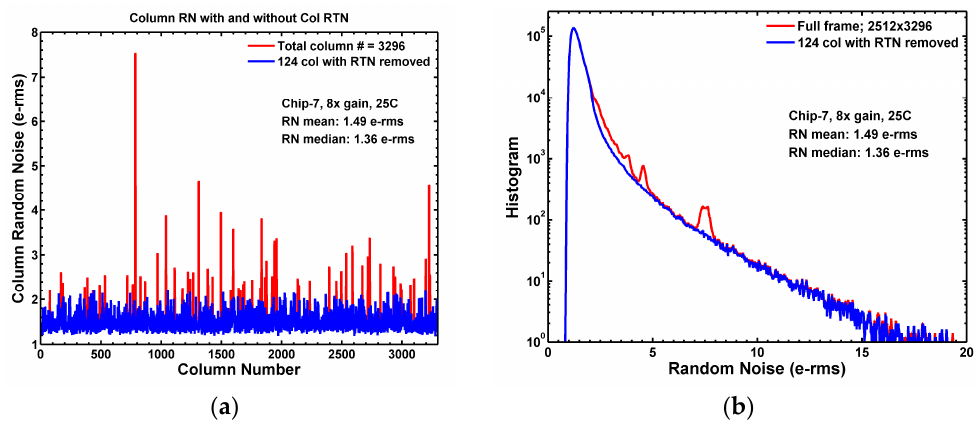
Figure 23. Column RN and pixel RN. ( a ) The column RN is defined as the average of the RMS of pixel RN for all pixels on the same column. The columns showing high noises are suspected to have RTN traps in the column bias devices. An empirical threshold was set such that these RTN columns are excluded in the pixel noise histogram calculation; ( b ) The noise histograms without deleting the RTN columns (red) show bumps and irregularities because a RTN trap in the column circuit boosts up the noises of all the pixels on the same column. The curve becomes smoother if the RTN columns are excluded (blue). This chip is different from the one shown in Figures 12 and 13.